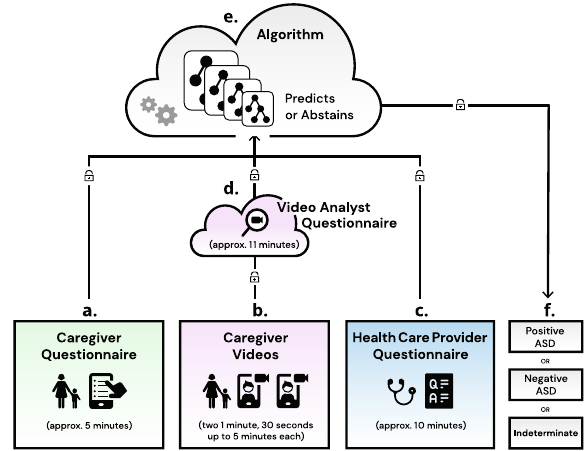
Fig. 1 Graphical representation of the Device and its major components. a Caregiver uses a smartphone to answer a brief questionnaire in approximately 5 min, b Caregiver uploads two short (1 min, 30 s up to 5 min) home videos of their child to be scored by trained video analysts, and c their primary care physician (or other quali fi ed healthcare provider) independently answers a short clinical question set in approximately 10 min. These inputs are securely transmitted to the d trained analysts where video features are extracted in approximately 11 min. e The caregiver, healthcare provider, and video analyst inputs are combined into a mathema- tical vector for machine-learning analysis and classi fi cation. f The Device provides an “ ASD positive ” or “ ASD negative ” or “ no result (indeterminate) ” output. The indeterminate output indicates infor- mation was insuf fi ciently granular to make a determination at that